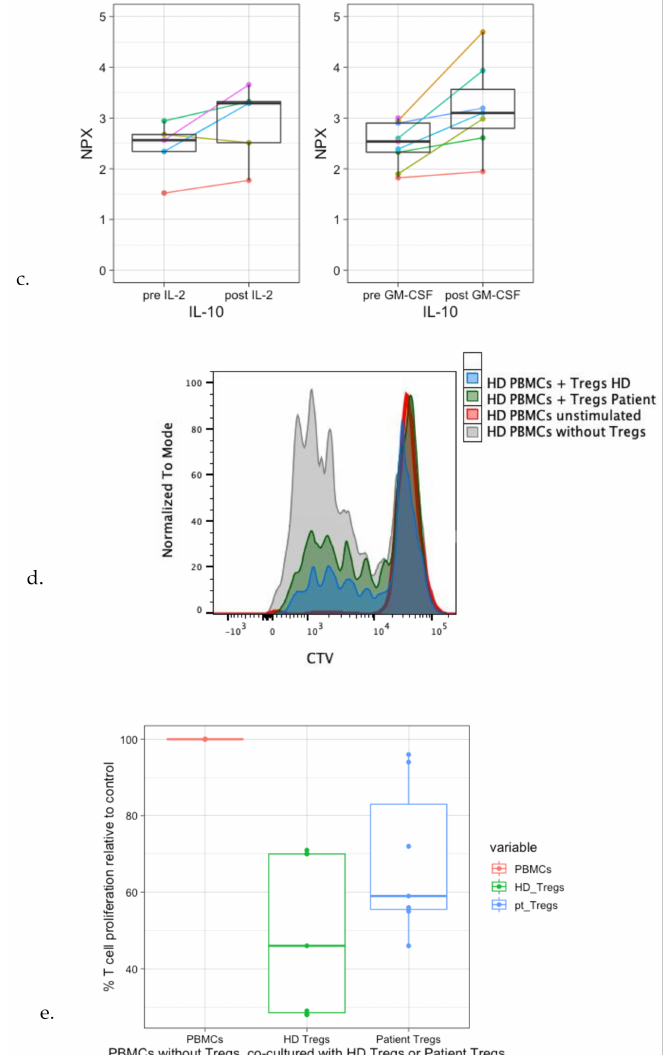
Figure 7. Regulatory T-cell profiles and their suppressive capacity during immunotherapy. ( a ) Exam- ple of gating of CD25 high CD127 dim cells within the CD3+CD4+ T-cell population (upper panels) and gating of FoxP3 within the CD25 high CD127 dim cell population before and after IL-2 administration (lower panels). ( b ) Percentages of Tregs (within CD3+CD4+ T-cell population) increase 4–5-fold after IL-2 administration (left) and increase 1–2-fold after GM-CSF administration (right). ( c ) Plasma IL-10 levels pre- and post-IL-2 ( p = 0.339) (left) and GM-CSF ( p = 0.144) (right). Protein expression is shown as normalized protein expression (NPX). IL-2: In total, 5 paired samples are shown, as two patients were monitored during both IT cycles. GM-CSF: In total, 7 paired samples are shown, as two patients were monitored during all three IT cycles. Two single measurements from patients pre-GM-CSF were included, resulting in a total of 9 patients pre- and 7 post-GM-CSF. ( d ) CTV staining of PBMCs of a healthy donor co-cultured without Tregs (grey), with patient Tregs (green), or healthy-donor Tregs (blue), or unstimulated (red) at an effector-to-target ratio of 2:1. ( e ) Relative percentages of proliferation of HD CD3+ T-cells co-cultured with patient Tregs (blue) or HD Tregs (green) compared to proliferation without Tregs (red). CD3+ T-cell proliferation was measured in patient 1 (during cycle 2 and 4), patient 2 (during cycles 1, 2 and 5) and patient 3 (during cycle 1 and 2). HD = healthy donor, PT = patient. ** p < 0.001, *** p < 0.0001. To subsequently determine whether patient Tregs are functional, a Treg crossover suppression assay was performed in which patient Tregs from different IT time points were co-cultured with healthy-donor PBMCs. Healthy-donor PBMC proliferation